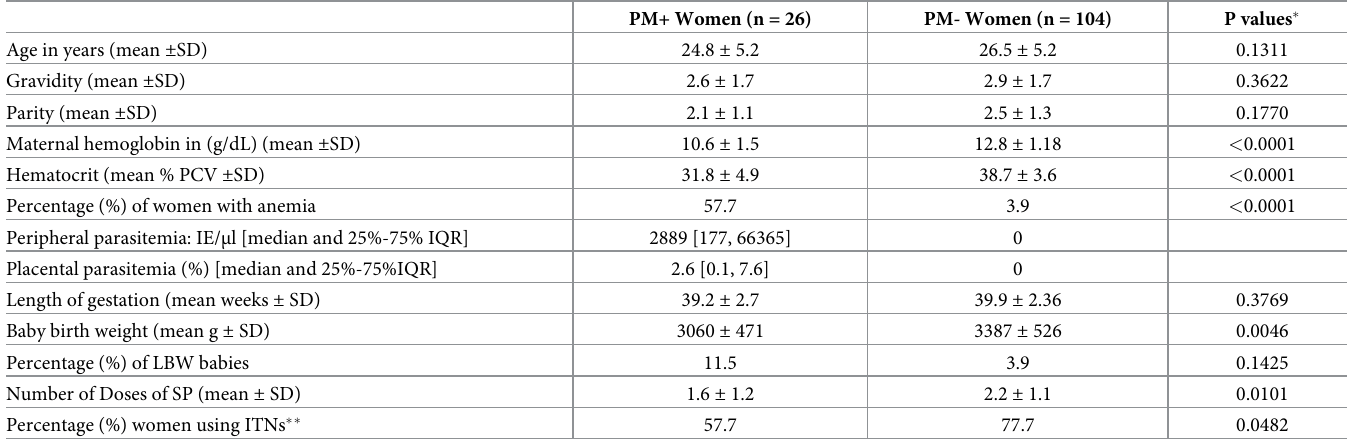
Table 1. Characteristics of the study